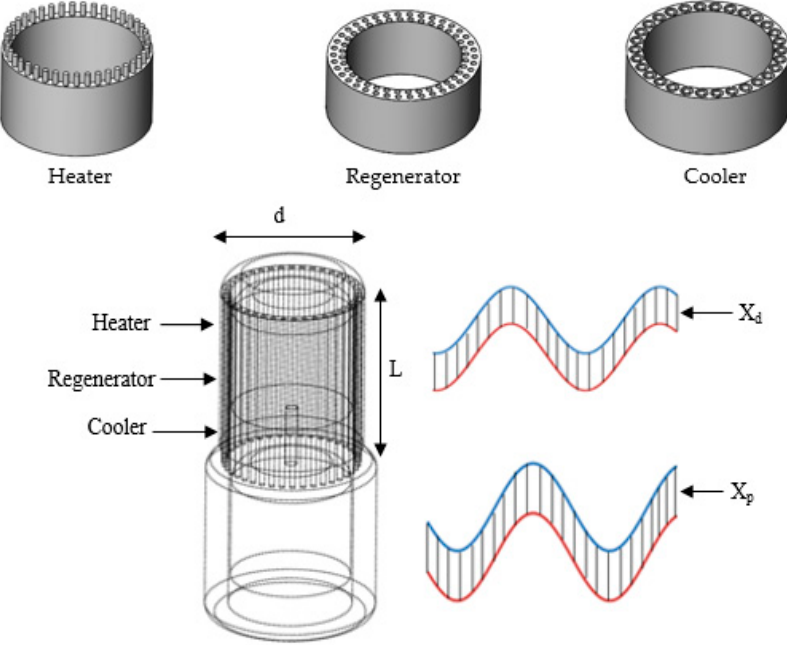
Figure 2. Schematic diagram of the free piston Stirling engine, including the heat exchangers, and the oscillation of the displacer and piston.